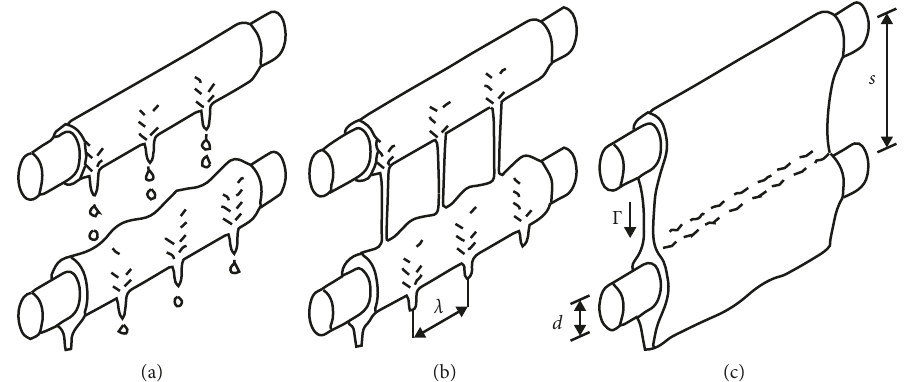
Figure 1: Sprinkling modes [7]. (a) Drop. (b) Jet (column). (c) Sheet.